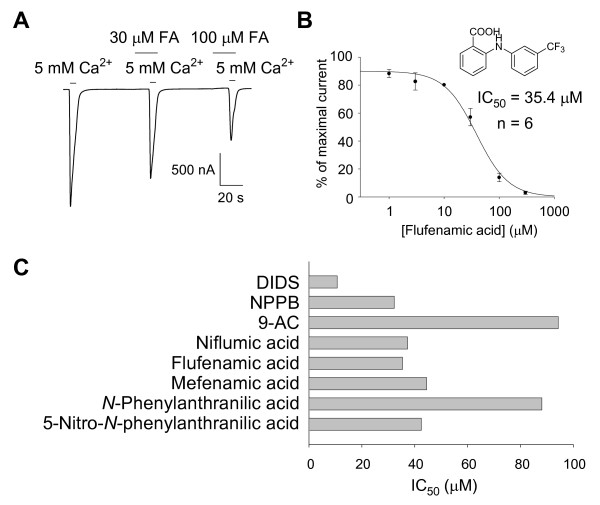
Effect of known blockers on Ca2+ activated Cl- channel. (A) Trace of Ca2+ activated Cl- channel current before and during application of flufenamic acid (FA). (B) Dose response relation of flufenamic acid block of Ca2+ activated Cl- current. (C) Summary of IC50s of commercially available blockers for Ca2+-activated Cl- channel. n indicates number of oocytes. Error bars indicate SEMs.